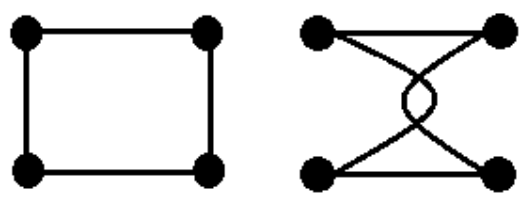
Figure 1. The same graphs but different